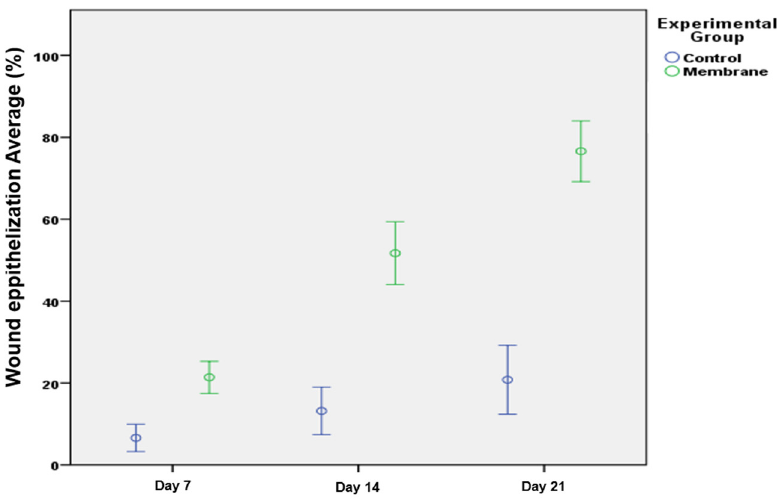
Figure 9. Wound epithelization in the different groups 7, 14 and 21 days postoperatively. Error bars represent 95% confidence intervals.